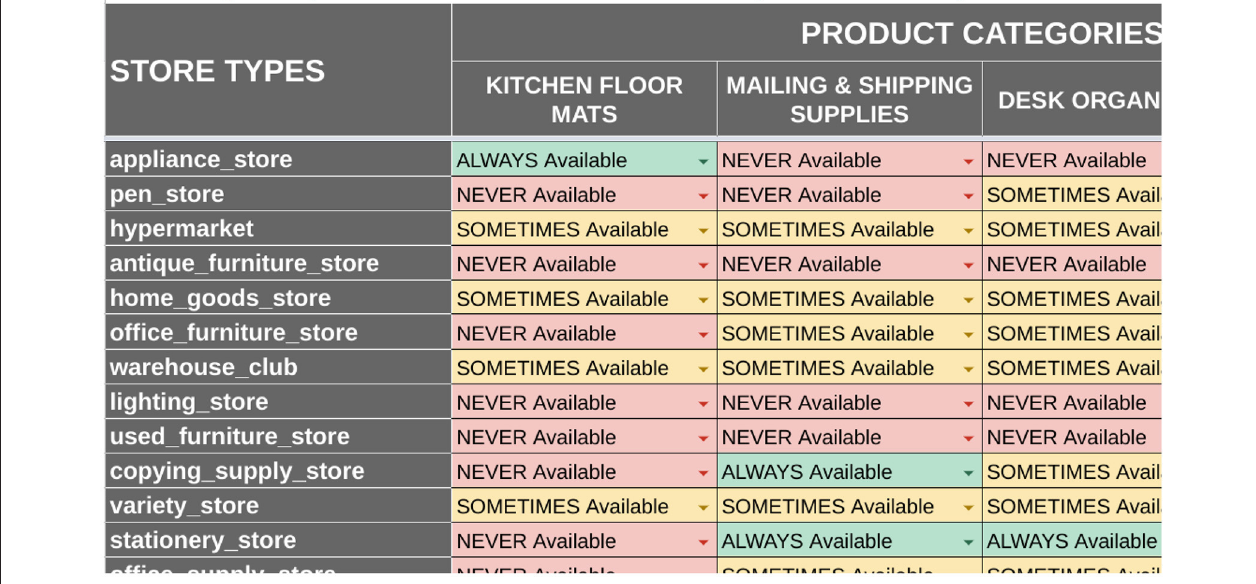
FIGURE 4 | Partial view of the PRODCAT data collection template with example answers from one